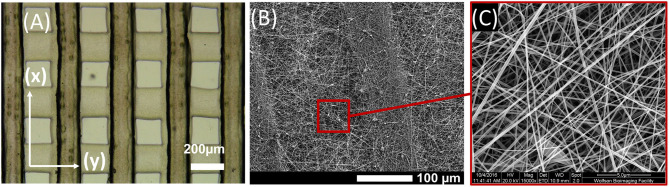
Fabricated multi-material scaffold. (A) Representative image of channel structure; (B) Representative SEM picture of the composite scaffold formed by gelatin (GL) nanofibers covering polylactic-co-glycolic acid (PLGA) cannels structure; (C) Representative SEM picture of the GL nanofibers.